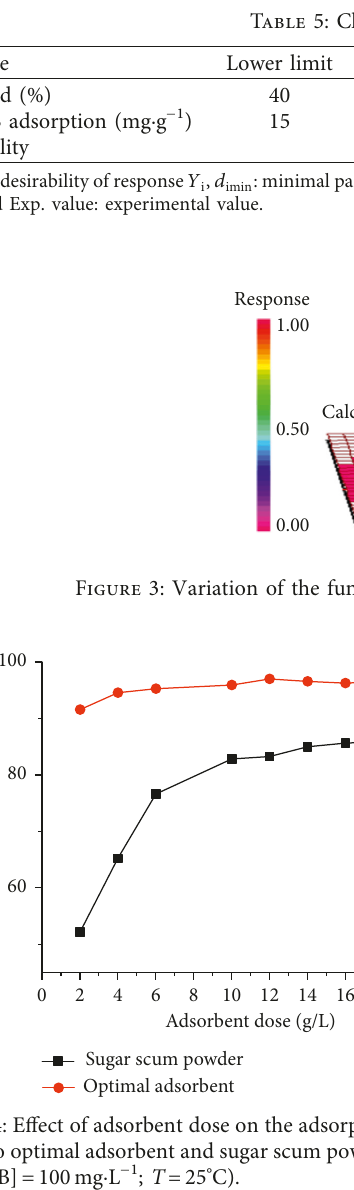
Table 5: Characteristics of maximum for responses Y